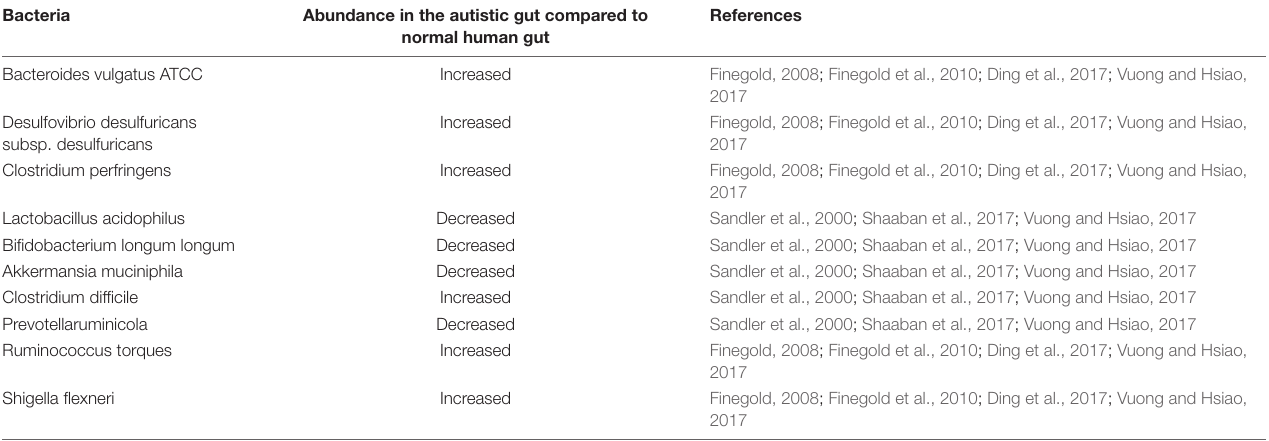
TABLE 1 | Gut bacterial abundance in autistic compared to normal human gut. Bacteria